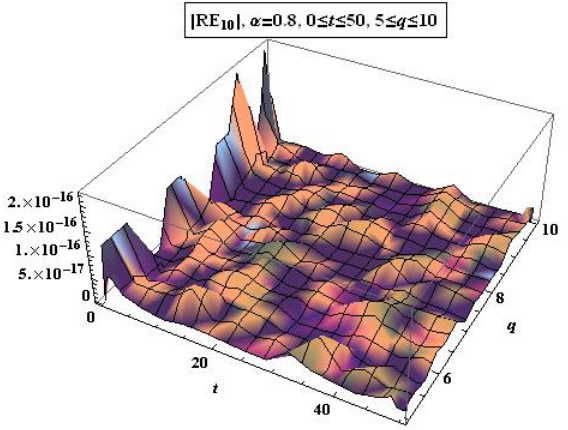
Figure 6. Residual at α = 0.8, λ = 1, 5 ≤ q ≤